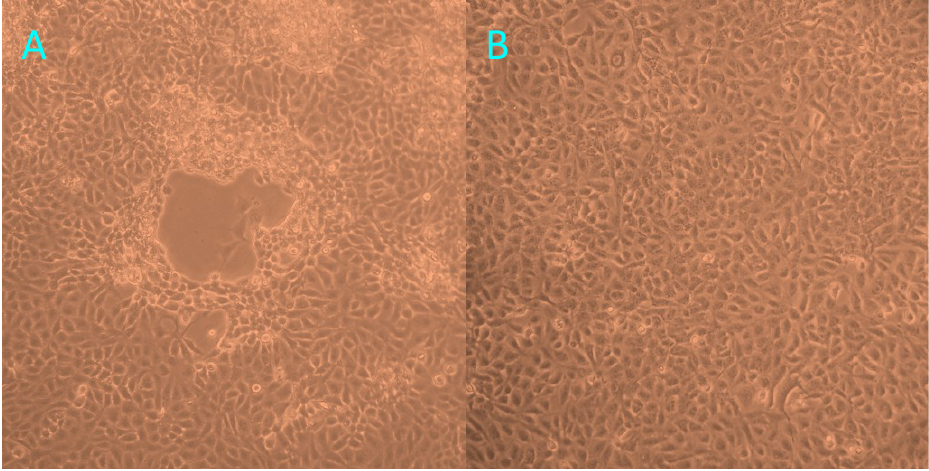
Figure 3. The cytopathic effect observed in FK81 cells inoculated with trachea homogenates from the tiger positive for FHV-1: 72 h post-inoculation ( A ); Normal Fk81cell lines ( B